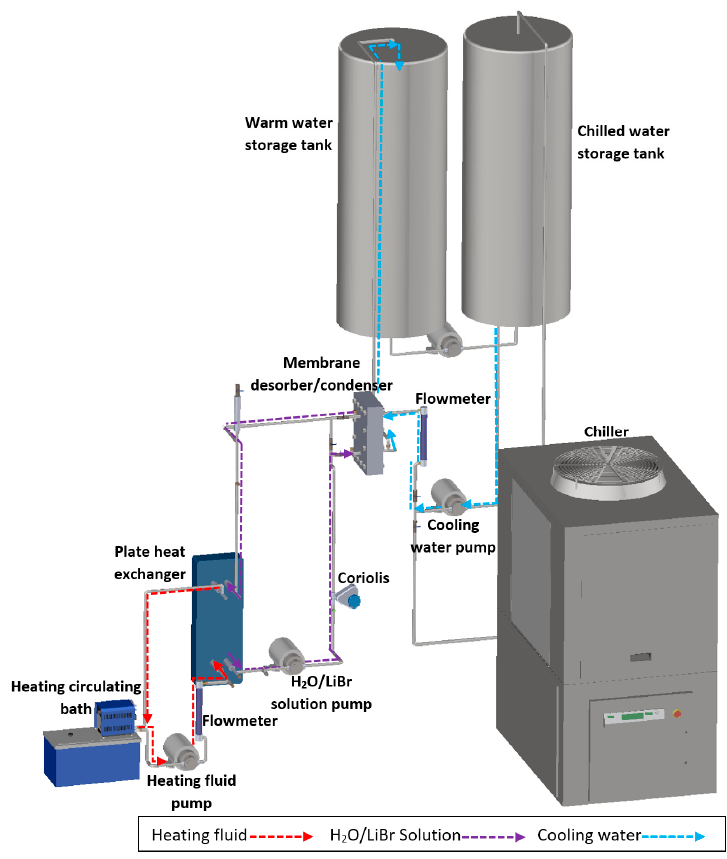
Figure 3. Schematic diagram of the experimental setup.